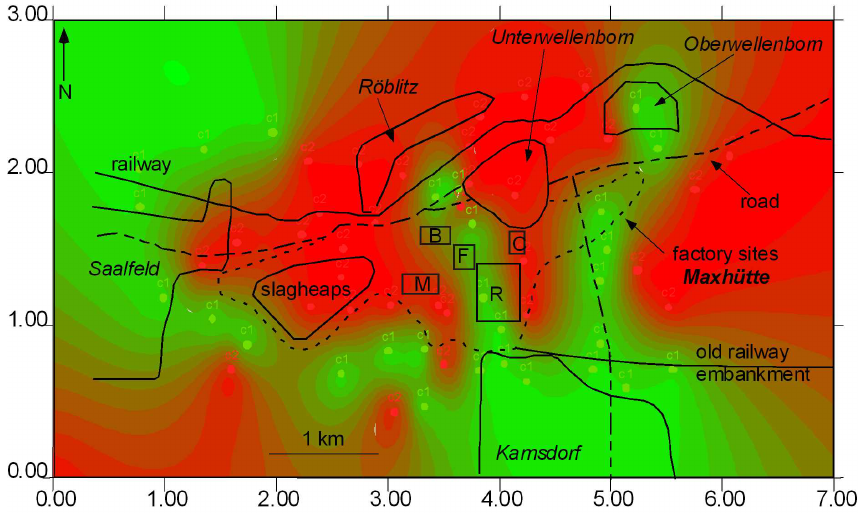
Fig. 3 Simultaneous presentation of the regional map, the 62 sampling sites and the two- dimensional information of the clustering according Fig. 5. The legend is the same as in Fig.